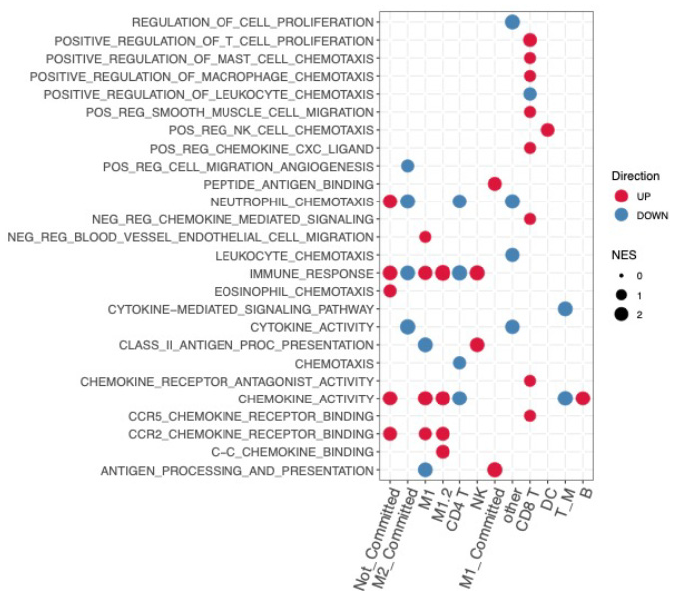
Figure 4. Gene set variation analysis. Results from GSVA analysis using the top up- and downregulated genes for each cell type/cluster. Red (positive) and blue (negative) dots indicate significant pathway normalized enrichment scores (NES), obtained by comparing the control to MCTP39-treated samples. Each cell type (x axis) was analyzed individually.